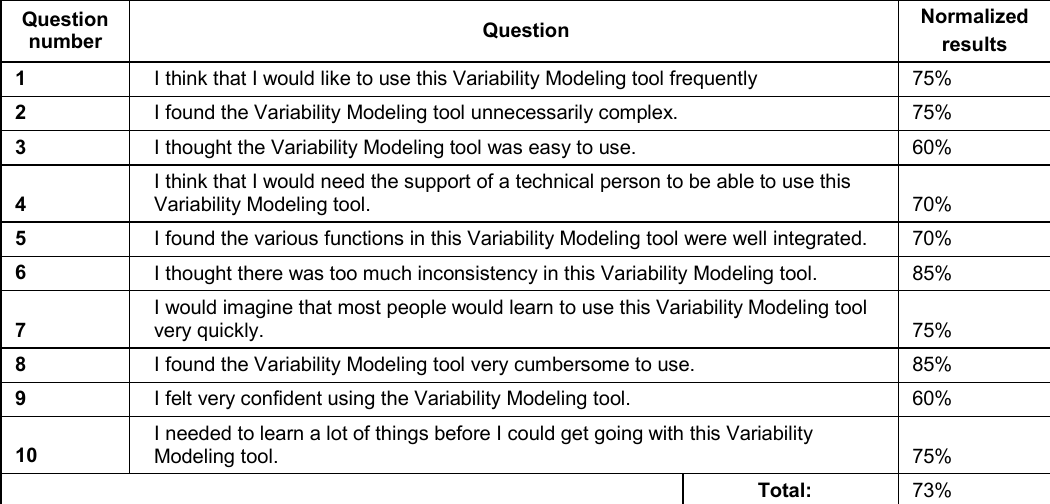
Table 5. Results of Satisfaction